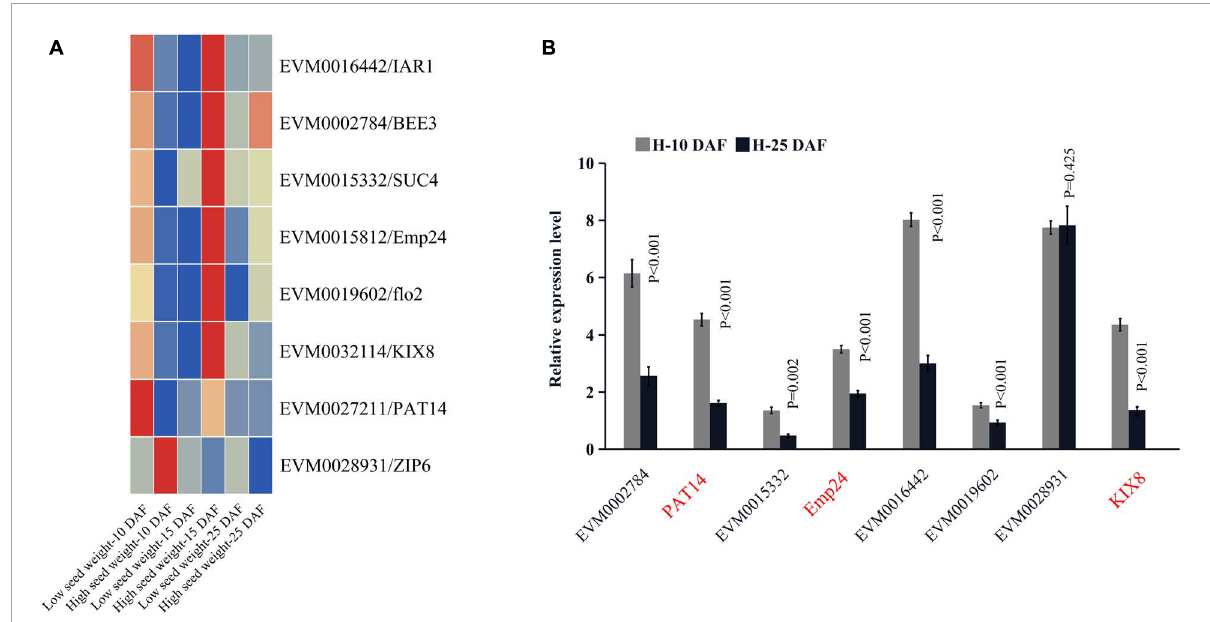
FIGURE3 The expression of eight key candidate genes. The expression profiling of eight key candidate genes significantly associated with seed-size-related traits. The expression profiling of eight key candidate genes between two high-seed-weight and two low-seed-weight mungbeans (A) . Real-time PCR analysis of the eight key candidate genes; the t -test was used to test the significant differences of genes expression between two high-seed-weight mungbeans at 10 DAF and 25 DAF (B) . DAF, days after